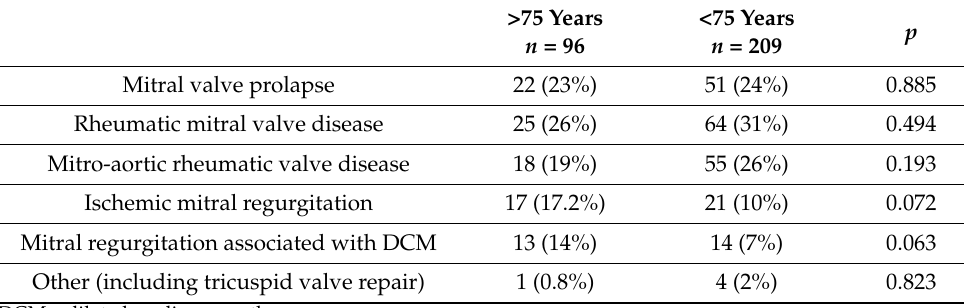
Table 2. Etiology of mitral valve